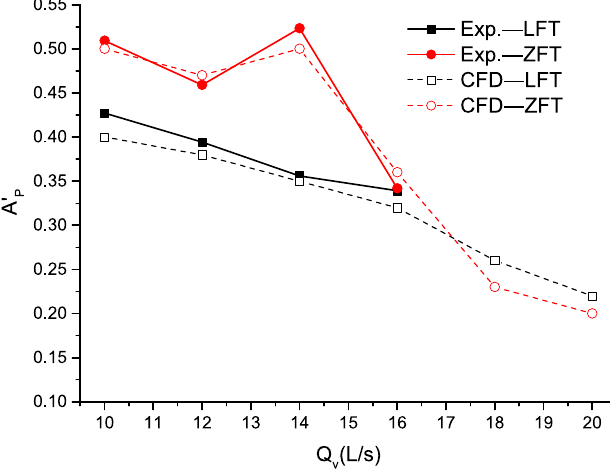
Figure 8. Relative pulse amplitude of pressure drop versus supply flow rate Q V .